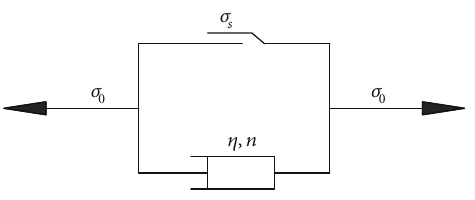
Figure 7: Nonlinear viscoplastic body (NVPB).